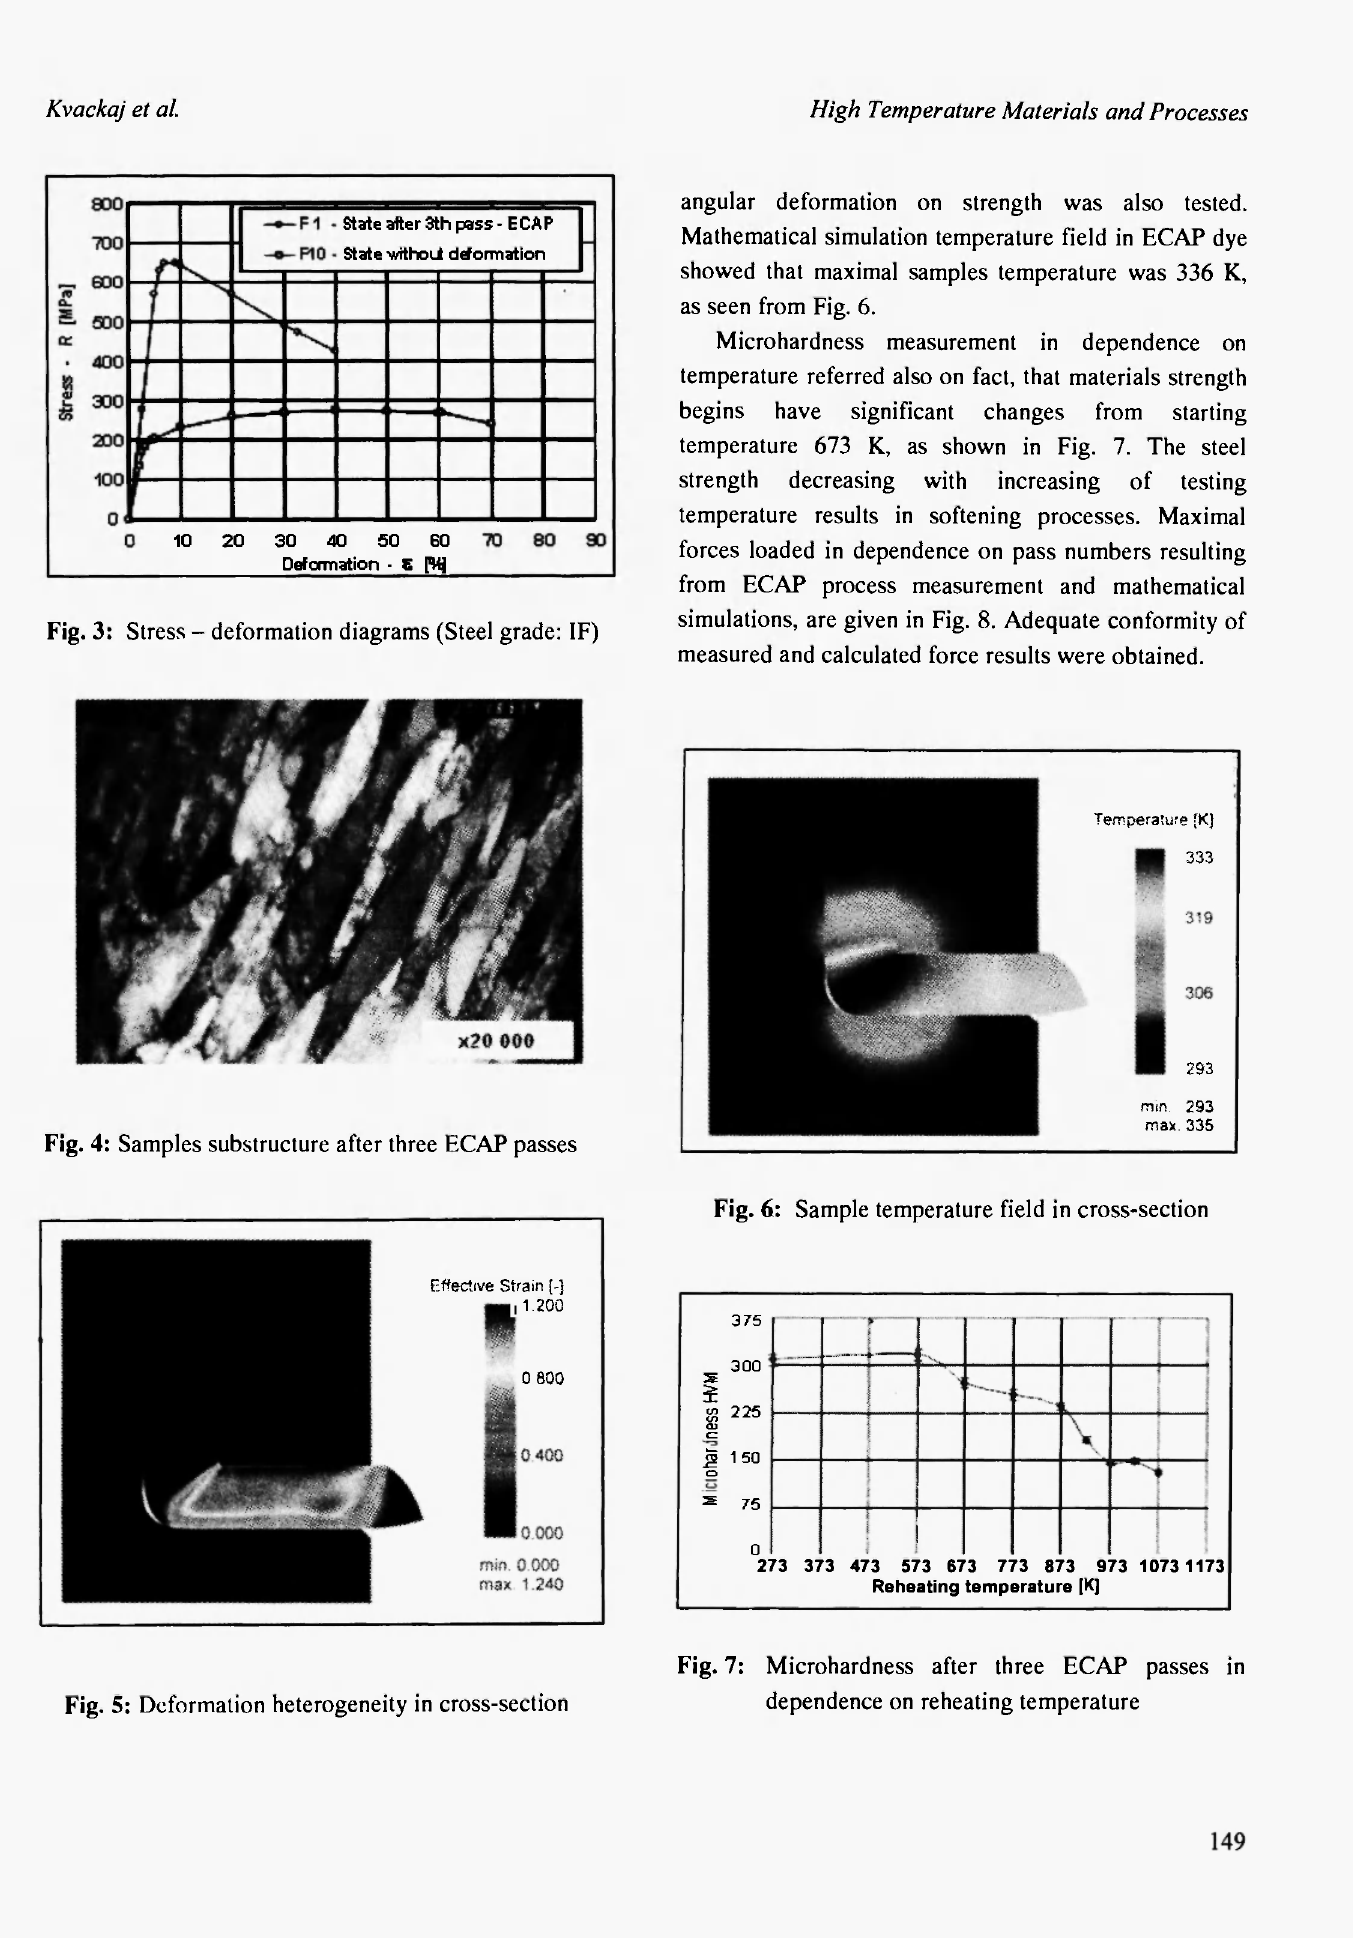
Fig. 7: Microhardness after three ECAP passes